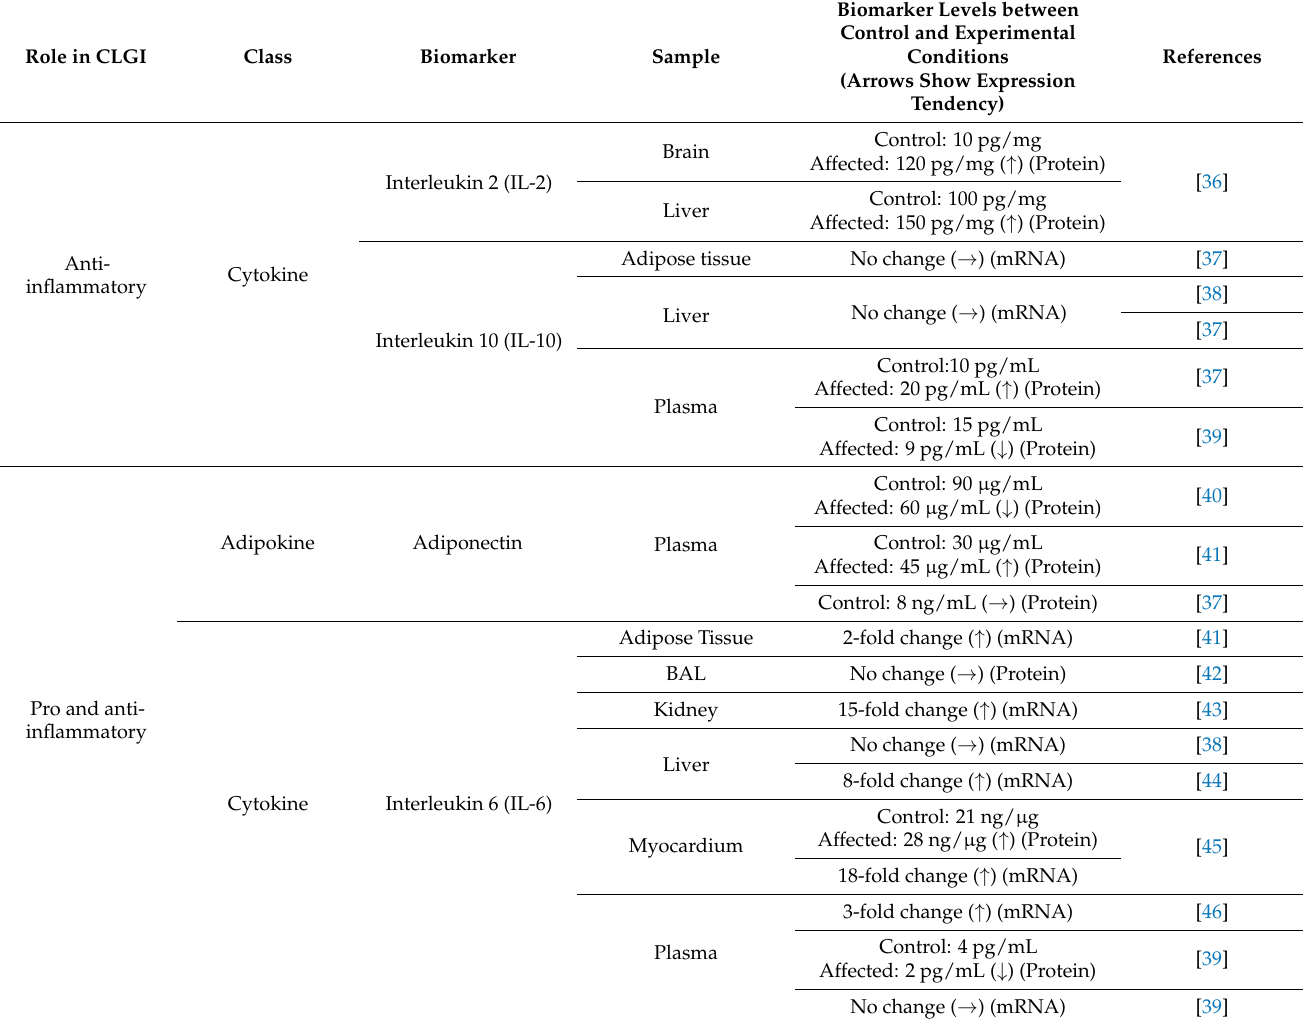
Table 1. Diet-induced CLGI biomarkers across publications on murine models.